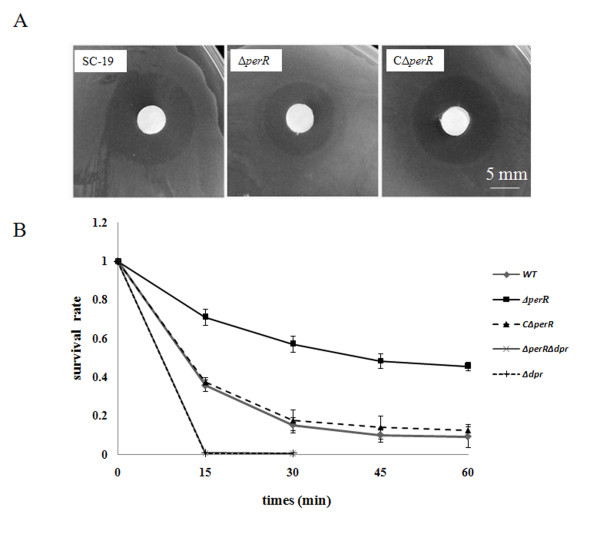
S. suissensitivity to peroxide stress. (A) The H2O2 sensibility was tested by disk diffusion assay. 1 M H2O2 was used. (B) The survival rates of wild-type (WT), ΔperR, CΔperR, Δdpr and ΔperRΔdpr at every 15 min in TSB with 10 mM of H2O2 challenge. Three independent experiments were performed.